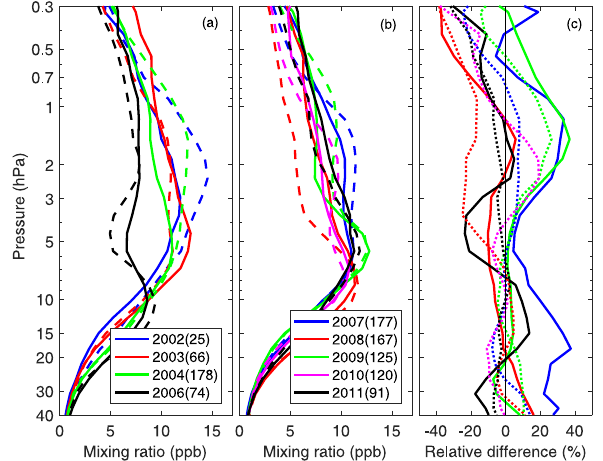
Figure 9. The median relative NO 2 difference (WACCM– GOMOS)/median(GOMOS) (in %) over 2002–2011. Latitudes are from − 90 to 90 ◦ with 10 ◦ resolution. A cross marks a point where the difference does not deviate from zero in a statistically significant way. A cell with a dot marks a point where there are no collocated